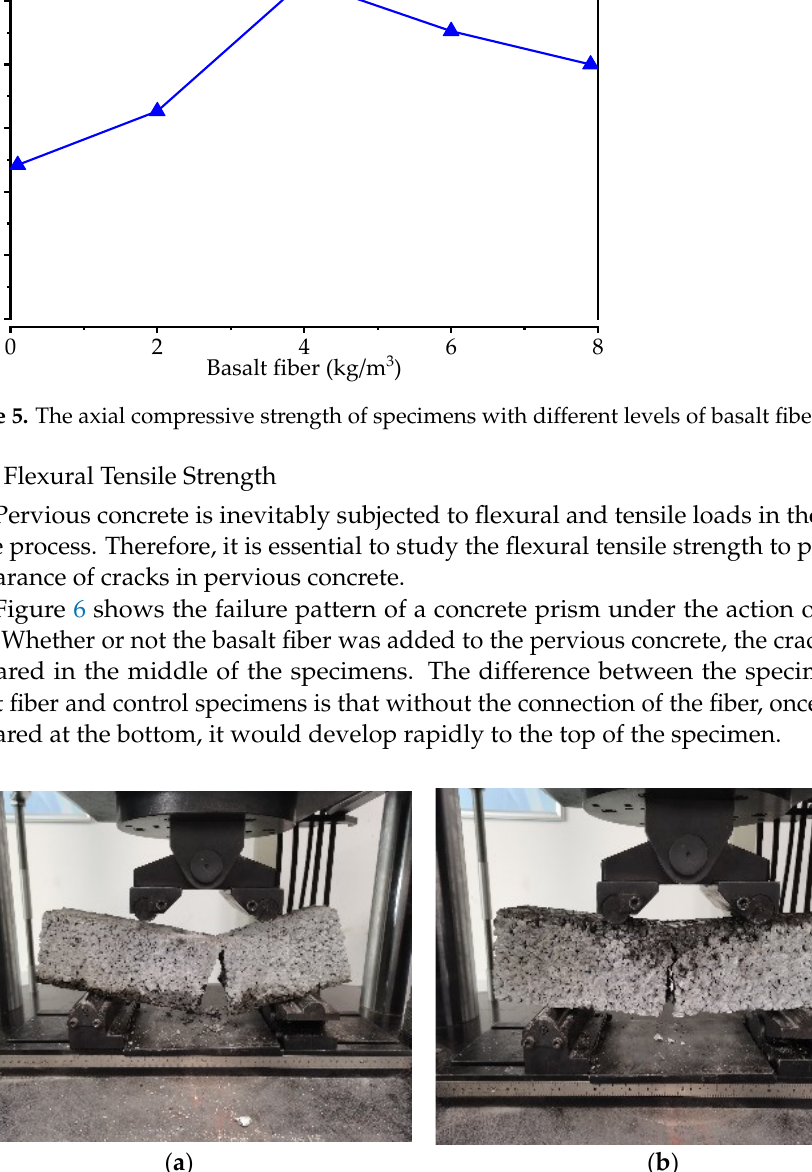
( b ) Figure 4. The failure patterns of ( a ) concrete prism without basalt fiber and ( b ) concrete prism with basalt fiber under axial compression.